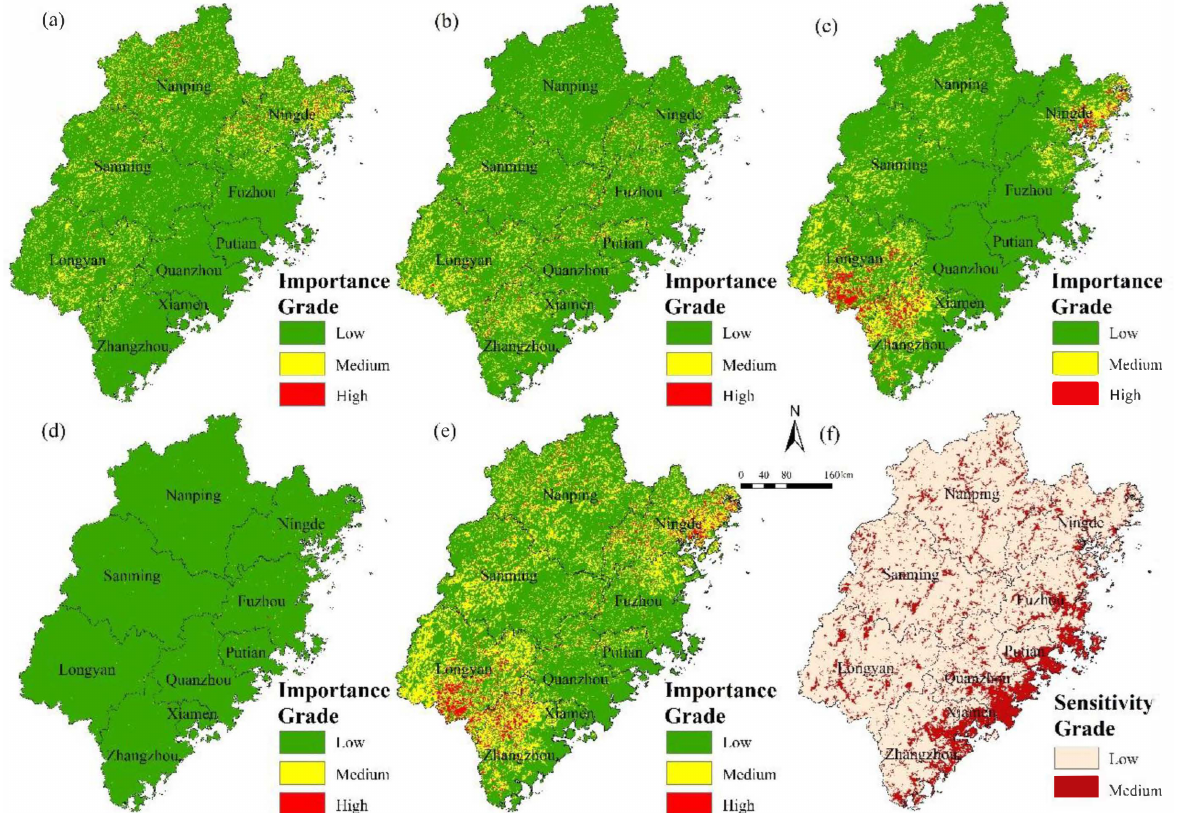
Figure 3. Evaluation results of the ecological service function importance and ecological sensitivity in Fujian. Evaluation results of ( a ) water conservation, ( b ) water and soil conservation, ( c ) biodiversity, ( d ) windbreak and sand fixation, ( e ) ecological service function importance, and ( f ) ecological sensitivity.3.2. Identification of Key Areas for Ecological